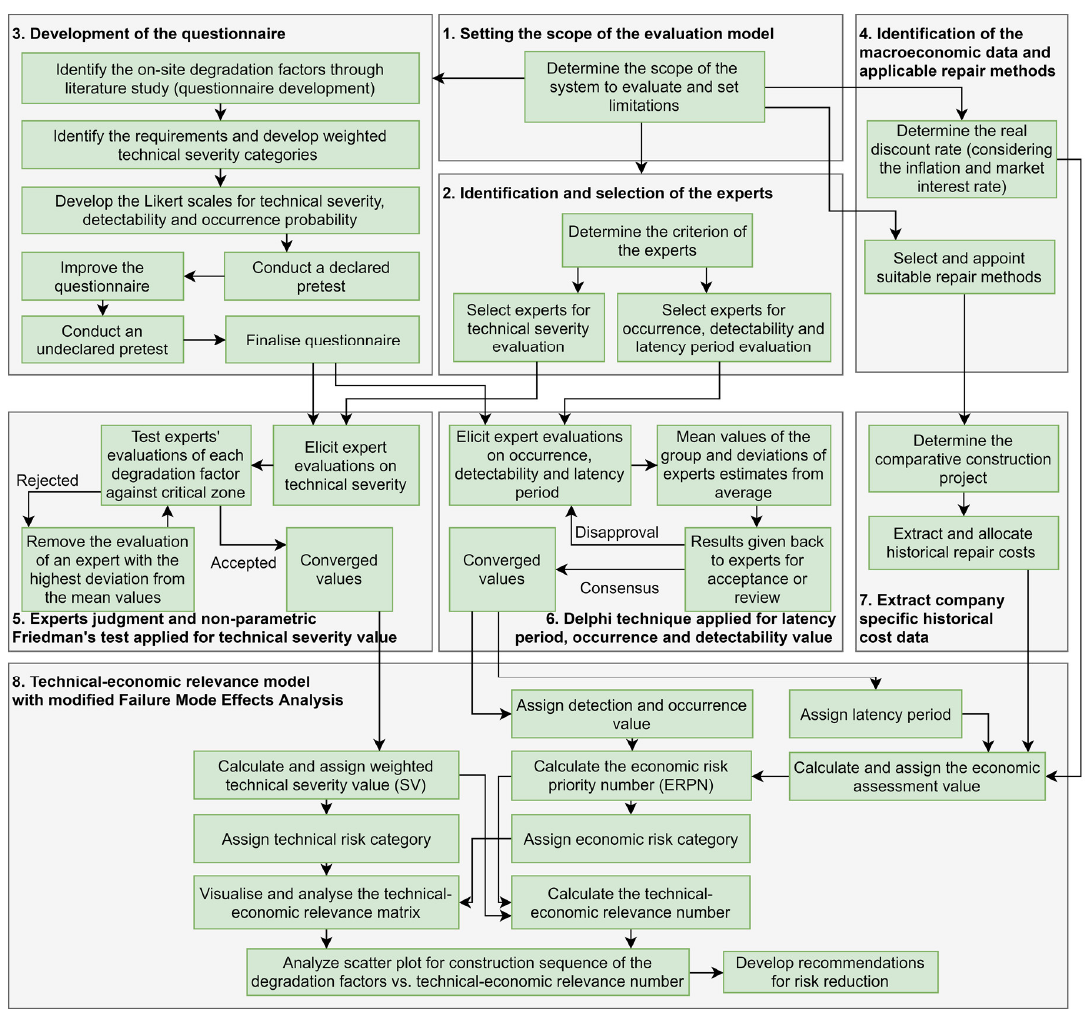
Figure 2. The research design of the technical–economic relevance (TER) model.